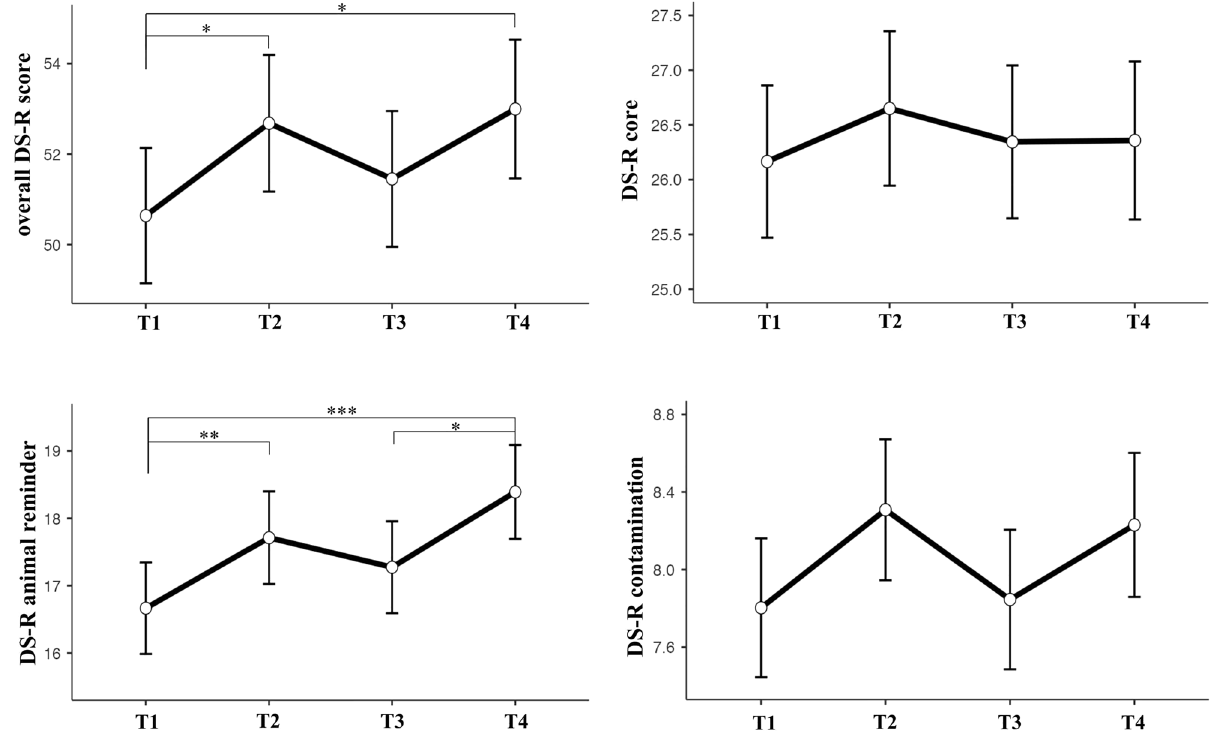
Figure 2. Longitudinal changes during pregnancy and after birth in the overall DS-R score and the core, animal reminder, and contamination subscales. T1-T3 corresponds to trimester numbers, with T4 being the measurement after birth. The significant differences of disgust sensitivity between periods, results of post hoc tests, are shown with * p < 0.05, ** p < 0.01 and *** p < 0.001. The graphs show the means and standard